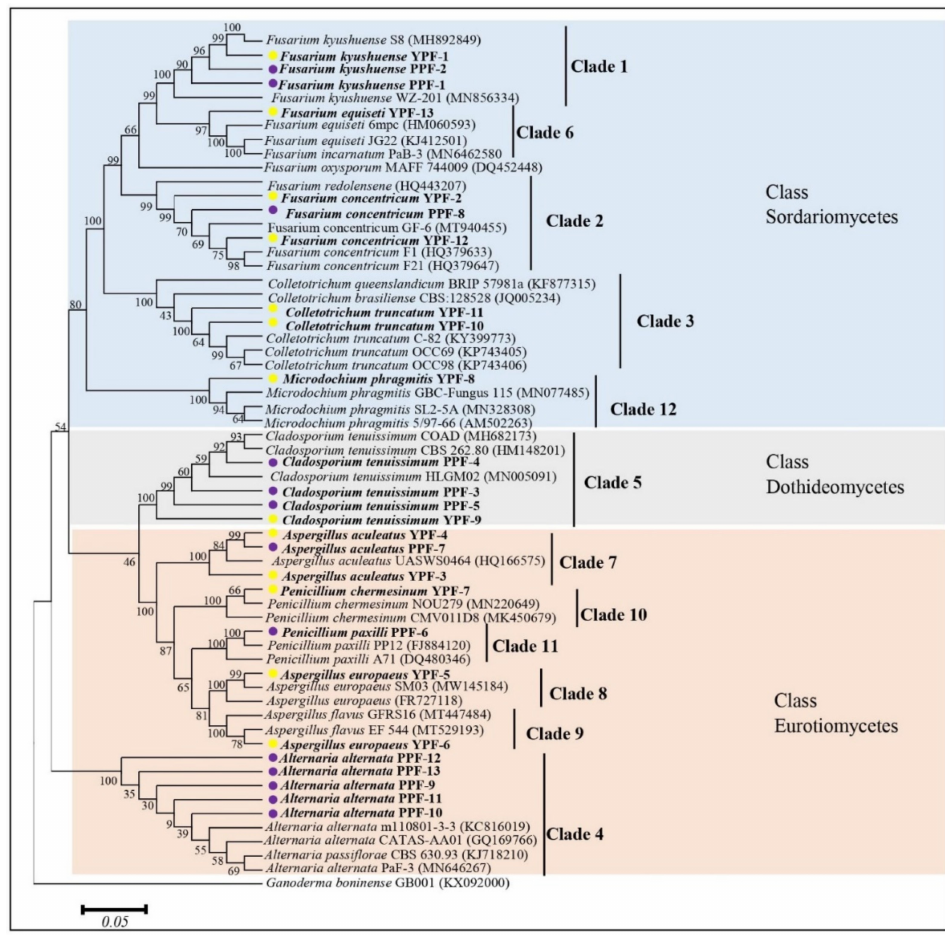
Figure 3. The evolutionary history of the twenty-six obtained isolates, presented in a phylogenetic tree on basis of neighbor joining and reference sequences from the NCBI GenBank database. The tree was constructed by analysis of ITS-rDNA sequences. Numbers at the nodes are the percentage of bootstrap support values of 1000 replicates. Ganoderma boninense GB001 (KX0920000) was used as an outgroup. The bar represents the 0.05 substitutions per nucleotide position and the isolates from the current study are presented in bold. Yellow and purple dots indicate the origin of the